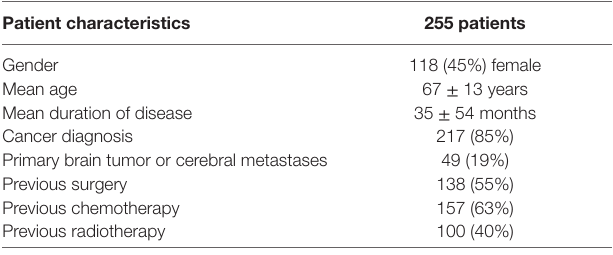
TaBle 1 | Analysis of patients’ medical records: patients’ characteristics and neurological